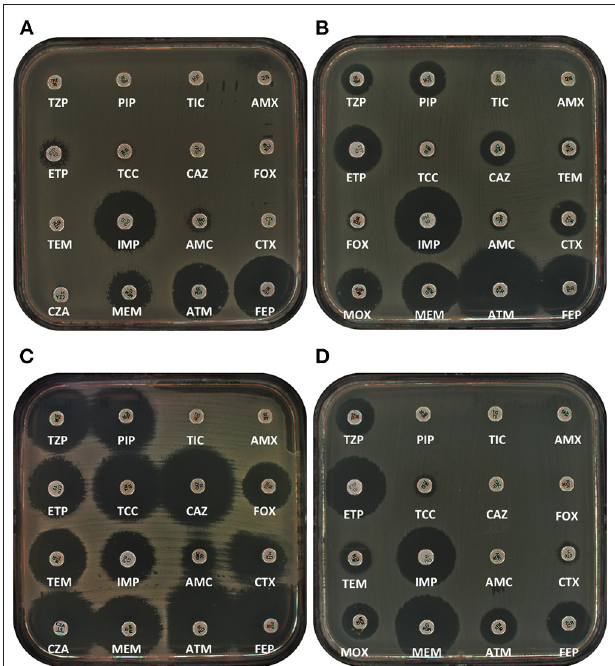
FIGURE 2 | Antibiograms of representative class B carbapenemases. (A) GIM-1-producing E. cloacae complex clinical isolate. (B) TMB-1 producing E. coli transconjugant. (C) SFH-1-producing S. marcescens clinical isolate. (D) LMB-1-producing C. freundii clinical isolates. AMX, Amoxicillin; AMC, Amoxicillin/clavulanate; ATM, aztreonam; CAZ, ceftazidime; CTX, Cefotaxime; CZA, Ceftazidime/avibactam; ETP, Ertapenem; FEP, Cefepime; FOX, Cefoxitine; IPM, Imipenem; MEM, Meropenem; PIP, Piperacillin; TCC, Ticarcillin/Clavulanate; TEM, Temocillin; TIC, Ticarcillin; TZP,